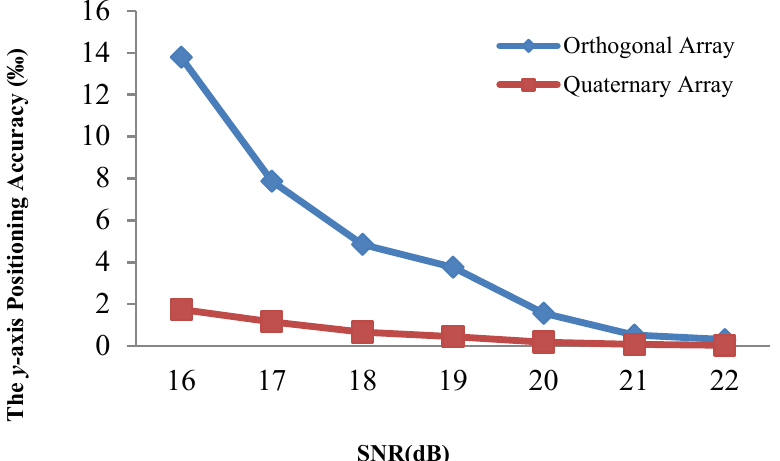
Figure 13. Comparison of the y-axis positioning accuracy of the adaptive residuals for different arrays and different SNR values.